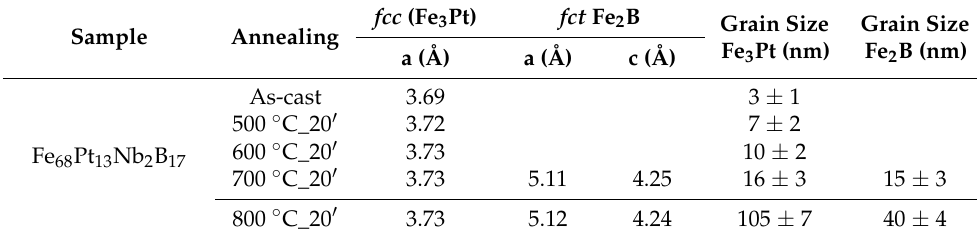
Table 1. The lattice parameters and the average grain sizes derived from the fit of the XRD spectra. Sample